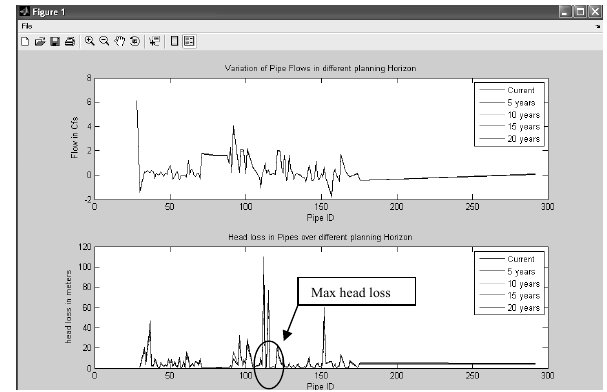
Figure 16. Variation of flows and heads over PH.